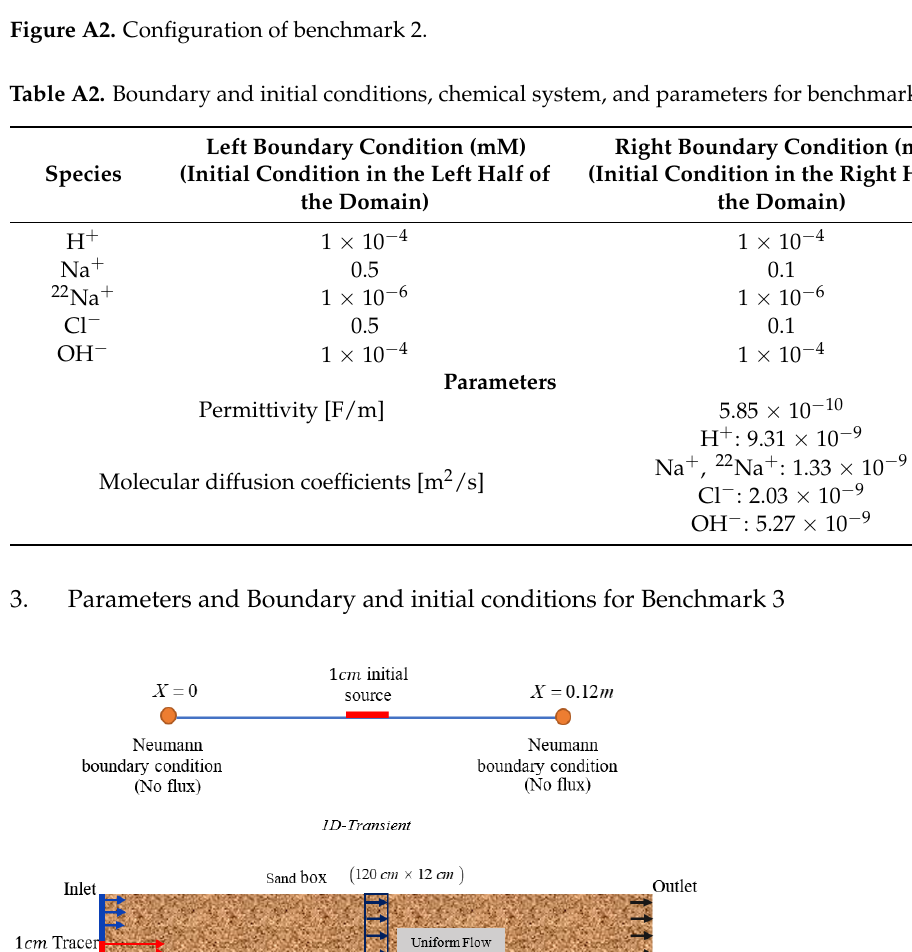
2. Parameters, boundary, and initial conditions for Benchmark 2